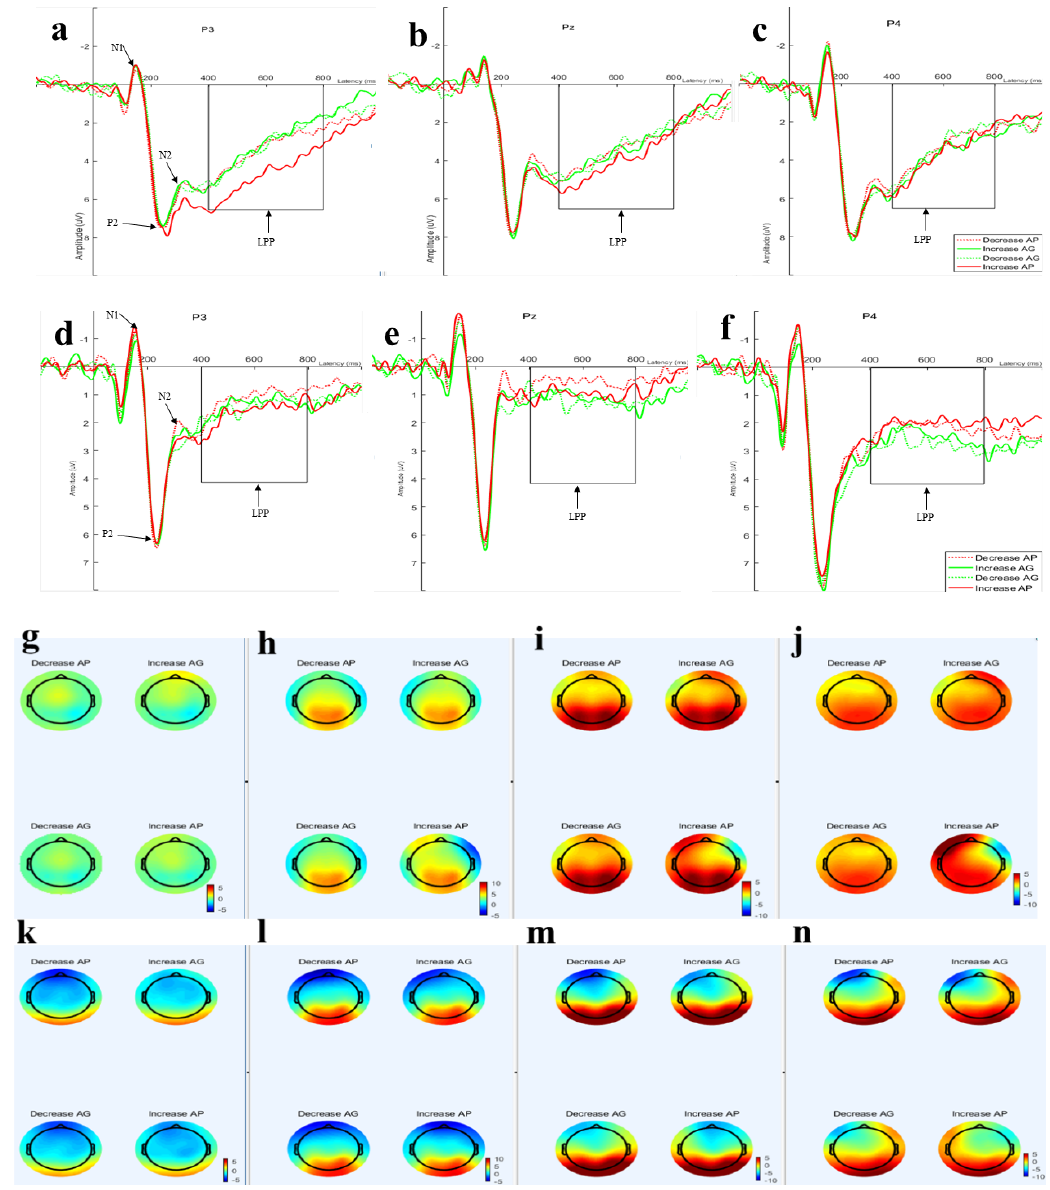
Figure 3. ERP components to emotion regulation at central-posterior. ( a – c ) Waveforms representing the average amplitude of the electrode points in the left ( a : P3), midline ( b : PZ), and right ( c : P4) brain regions, respectively, under the context of the HAV; and ( d – f ) the LAV, the electrode points in the left ( a : P3), midline ( b : PZ), and right ( c : P4) brain regions, respectively. The voltage topography ( g – j ) is displayed in the corresponding time windows, showing the scalp distribution at 140–160 ms ( g : N1), 200-280 ms ( h : P2), 270-330 ms ( i : N2), and 400-800 ms ( j : LPP) within the context of the HAV, and ( k : N1) \ ( l : p2) \ ( m :N2) \ ( n : LPP) within the context of